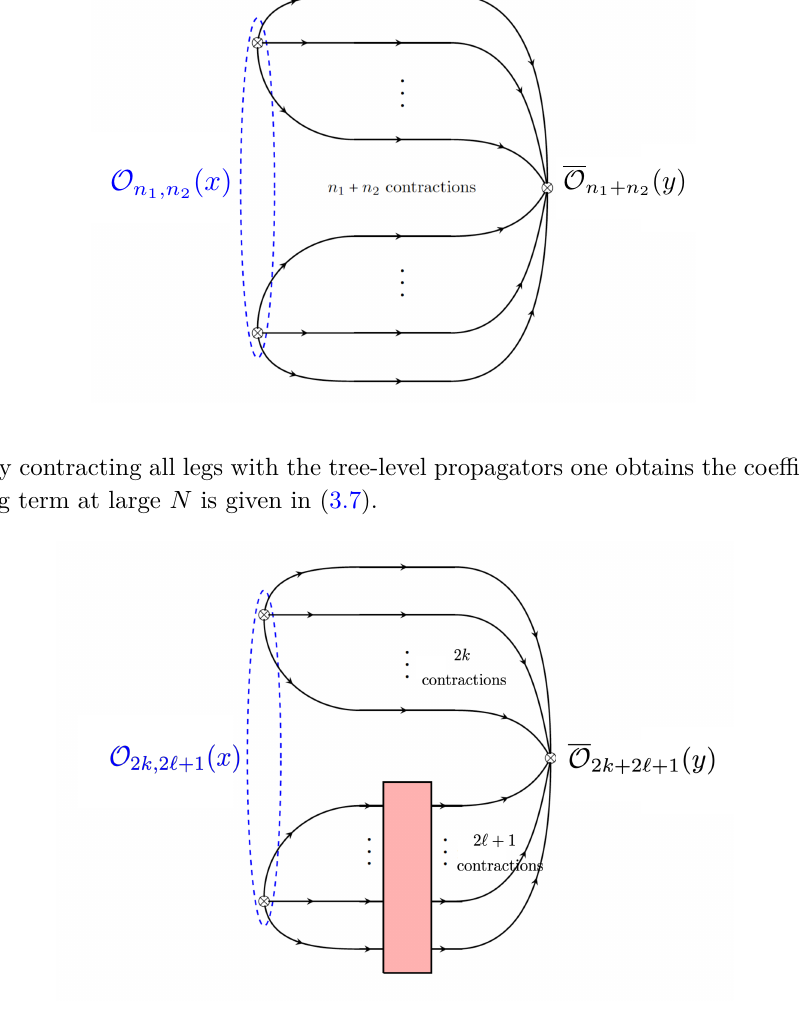
Figure 7 . The effective vertex of figure 3 is used in the contraction of the (2 ‘ + 1) legs and yields a planar contribution proportional to ζ (4 ‘ + 1) λ 2 ‘ +1 in the 3-point function G 2 k, 2 ‘ +1